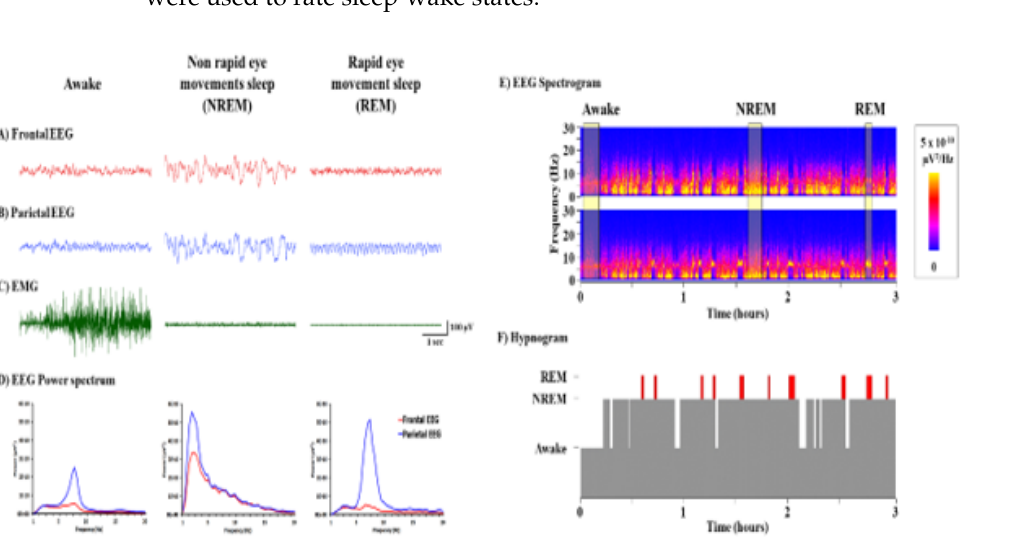
Figure 4. ( A , B ) Frontal and Parietal EEG, ( C ) EMG, ( D ) EEG Power Spectrum, ( E ) EEG Spectrogram, ( F )